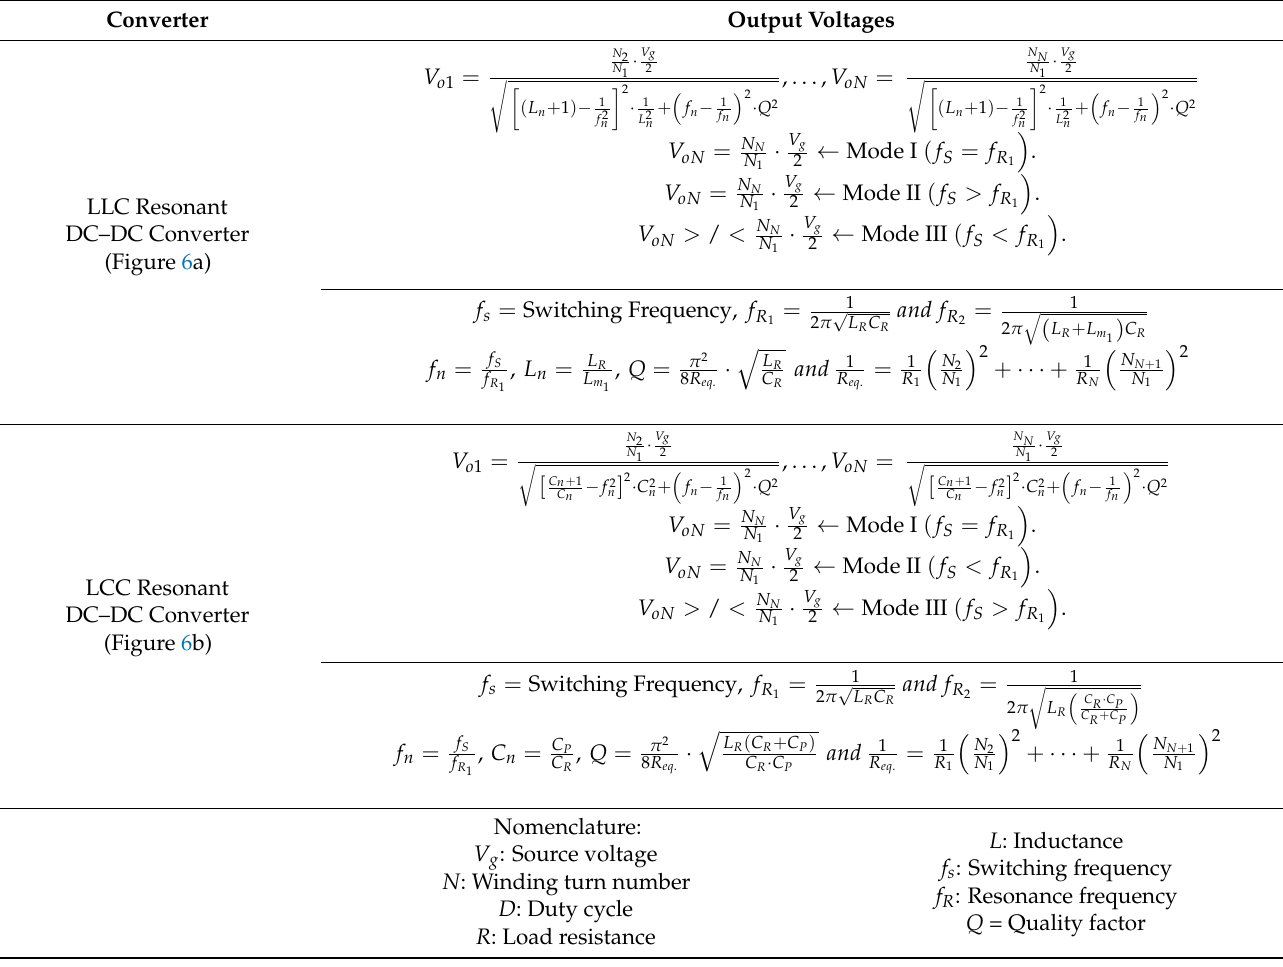
Table 3. Conversion relations for Multiple-Output Isolated Resonant DC–DC Converters.